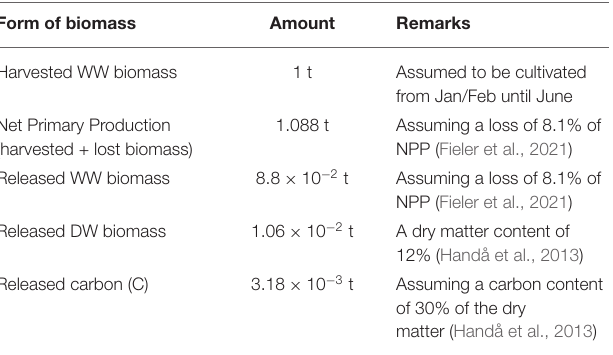
TABLE 2 | Relations/assumptions between production and release of organic matter/release of matter per 1 t harvested biomass. Form of biomass